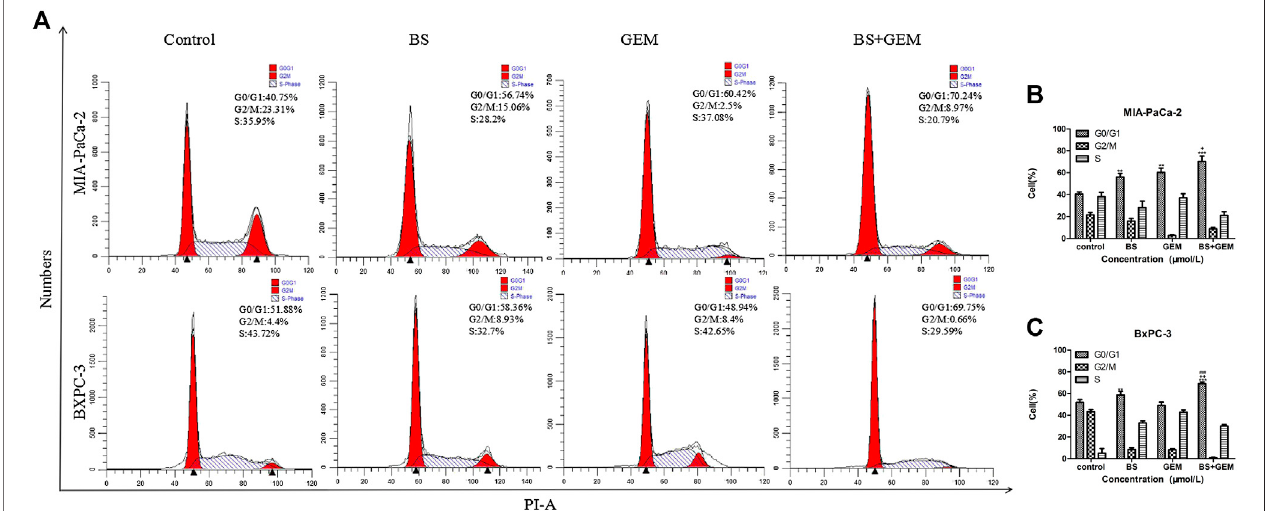
FIGURE 6 | Combination of β -sitosterol (BS) and gemcitabine (GEM) affect cell cycle progression of pancreatic cancer cells. MIA-PaCa-2 and BXPC-3 cells were treated withBS (250 μ M/L) and GEM(50 μ M/L) alone and incombination for 48 h and analyzed by fl owcytometry. (A – C) Cell cycle distribution in theG0/G1 phase was observed to be augmented in the combination group compared with either one ofthe agents group. All data are depicted as mean ± SD ( n (cid:1) 3; ** p < 0.01; *** p < 0.001; + p < 0.05; ++ p < 0.001; ### p < 0.001).